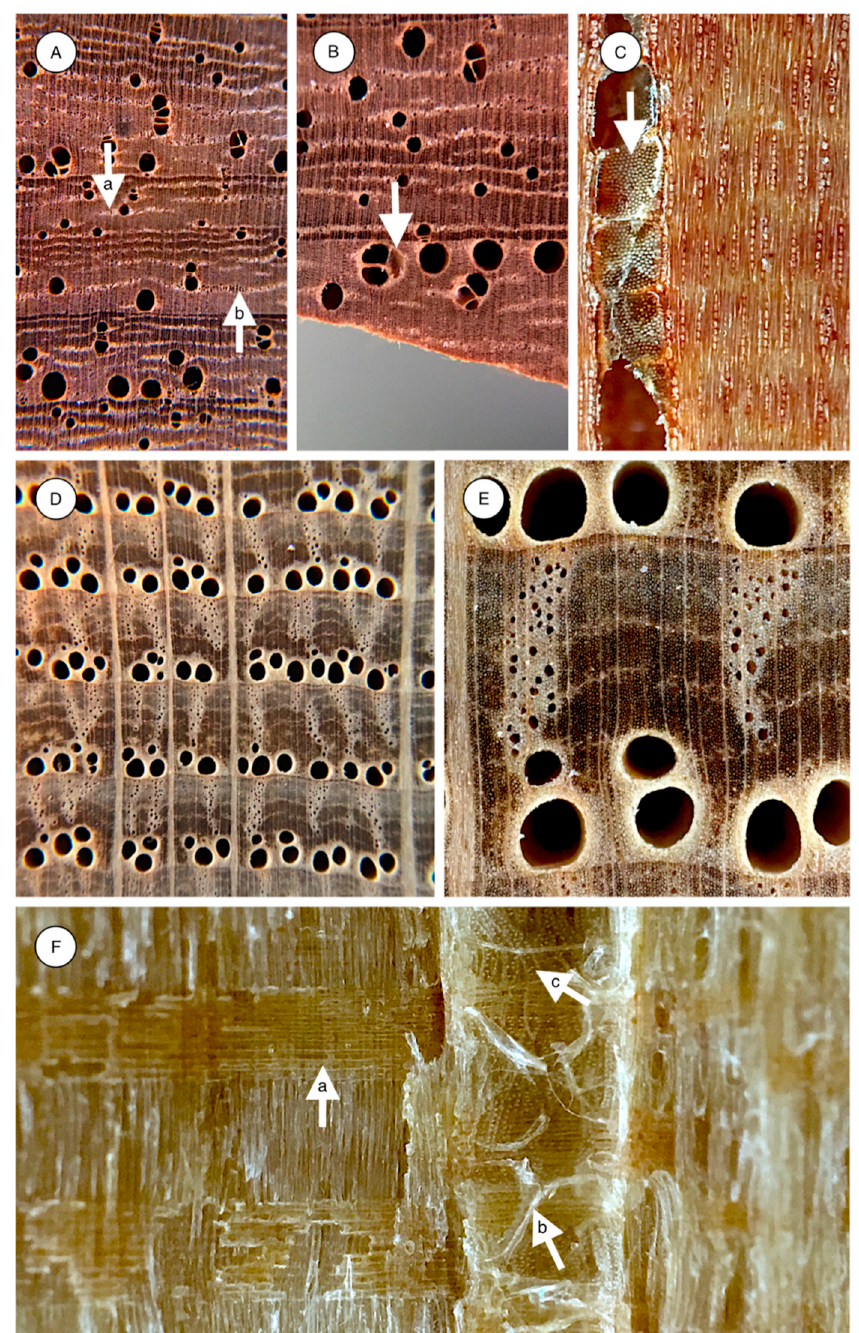
Figure 11. Elements visible with 400 × lens in hardwoods. Pterocarpus santalinus L.f. ( A ) ( a ) Winged-aliform axial parenchyma; ( b ) confluent axial parenchyma. ( B ) Deposits. ( C ) Alternate polygonal pits. Quercus mongolica Fisch. ex Ledeb. ( D ) Ring-porous wood. ( E ) Latewood vessels polygonal in outline. ( F ) ( a ) Homocellular rays with procumbent cells; ( b ) tyloses; ( c ) vasicentric tracheids.